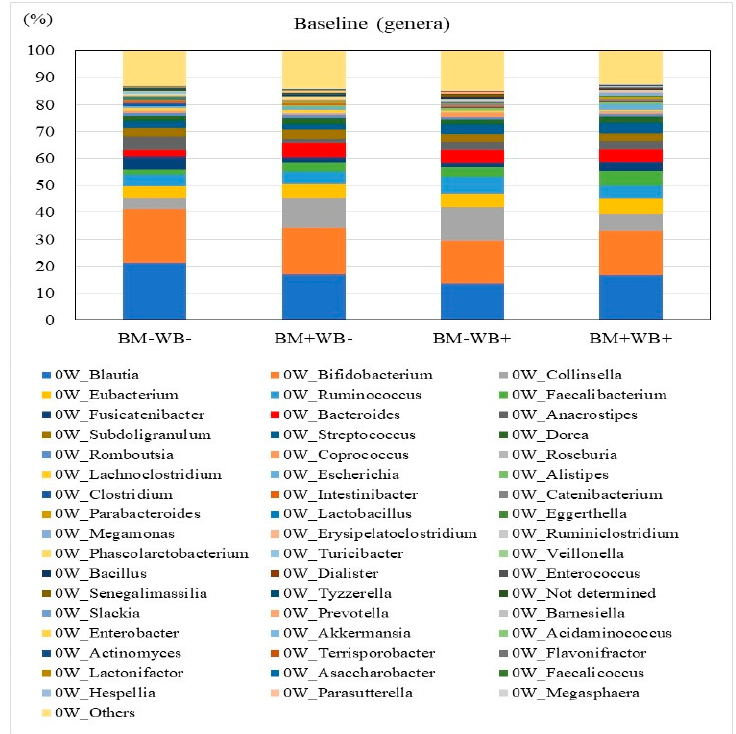
Figure 3. The average relative abundances of detected bacteria genera in stool samples obtained at baseline. No significant differences were observed among the test groups at baseline .